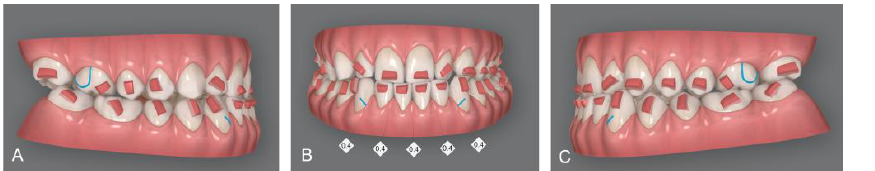
Figure 4. Invisalign ® software display of attachments, programmed IPR and cuts for elastic: Right lateral vision of virtual setup ( A ); Frontal vision of virtual setup; IPR of 0.4 mm from canine to canine was planned ( B ); Left lateral vision of virtual setup ( C ).